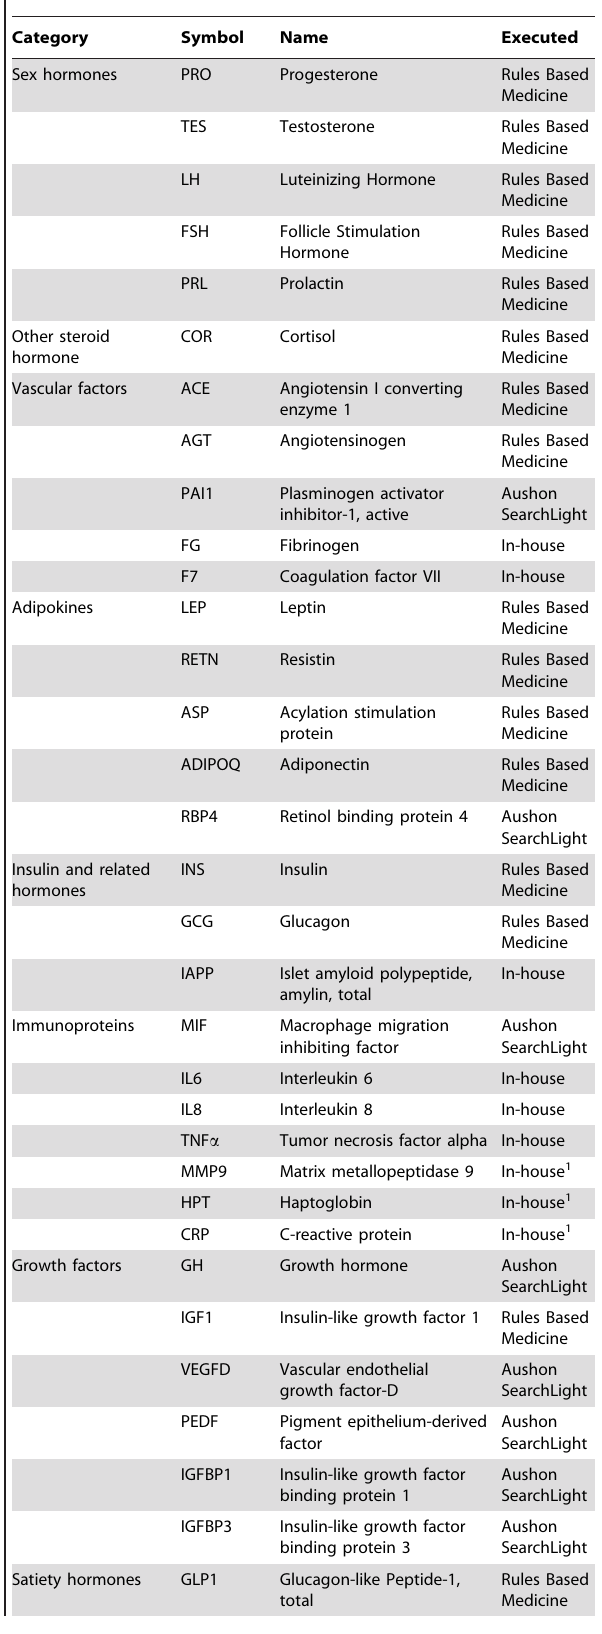
Table 1. List of analyzed blood proteins and